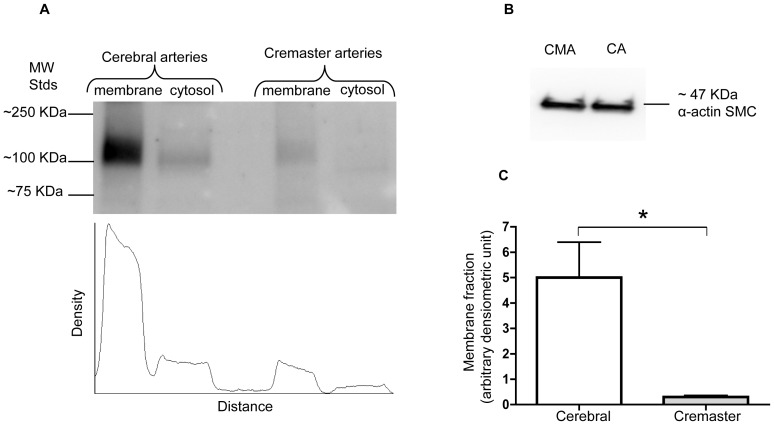
Quantification of cell surface expressed α-BKCa channels in cerebral vs cremaster arteries.Total amount of membrane α-BKCa channel in cerebral arteries is approximately 20 times higher than that in cremaster arterioles. The Western blot in panel (A) shows a representative experiment depicting the distribution of α-BKCa protein in membrane and cytosolic fractions prepared from cerebral arteries and cremaster arterioles. The scan beneath the blot quantifies the intensity of the α-BKCa protein immunoreactive band in each sample, as detected by densitometry. The Western blot in panel (B) shows a loading control in which 2 µg of total protein for both cerebral arteries (CA) and cremaster arterioles (CMA) was probed with α-actin SMC antibody. Panel (C) shows group data for n = 5 experiments. Results are shown as mean ± SEM (*P<0.05, unpaired t-test).